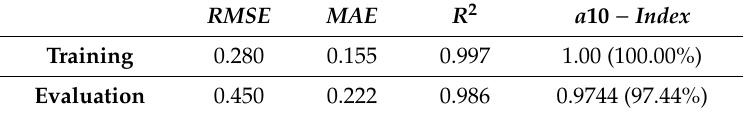
Table 5. Performance of the selected model for convergence prediction.